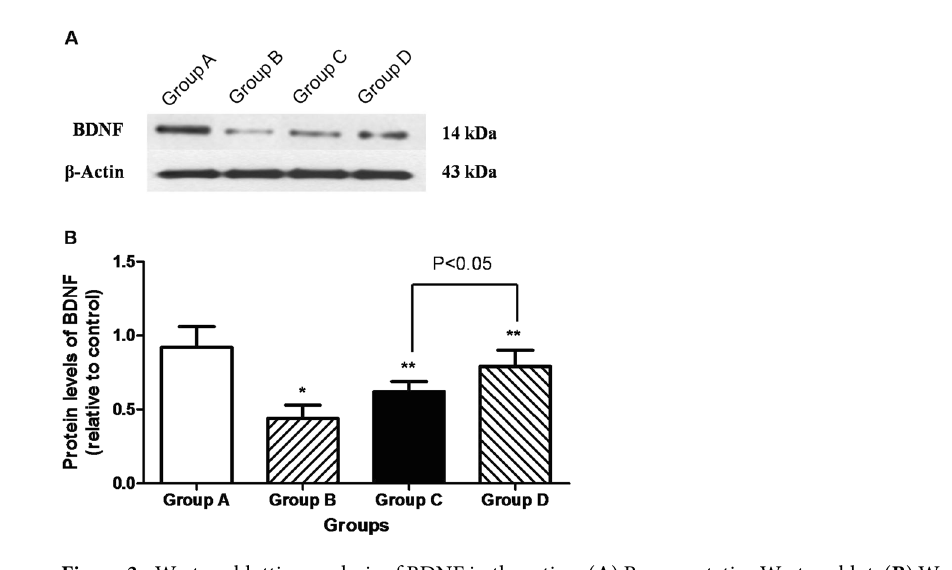
Figure 3. Western blotting analysis of BDNF in the retina. ( A ) Representative Western blot; ( B ) Western blot analysis. There were significant differences in the level of retinal BDNF protein between rats with DR (Group B: n = 6) and Group A (n = 6). In contrast, the level of BDNF protein increased in Groups C and D. Retinal BDNF protein levels in Group D were higher than that in Group C. * P < 0.05 vs. Group A; ** p < 0.05 vs. Group